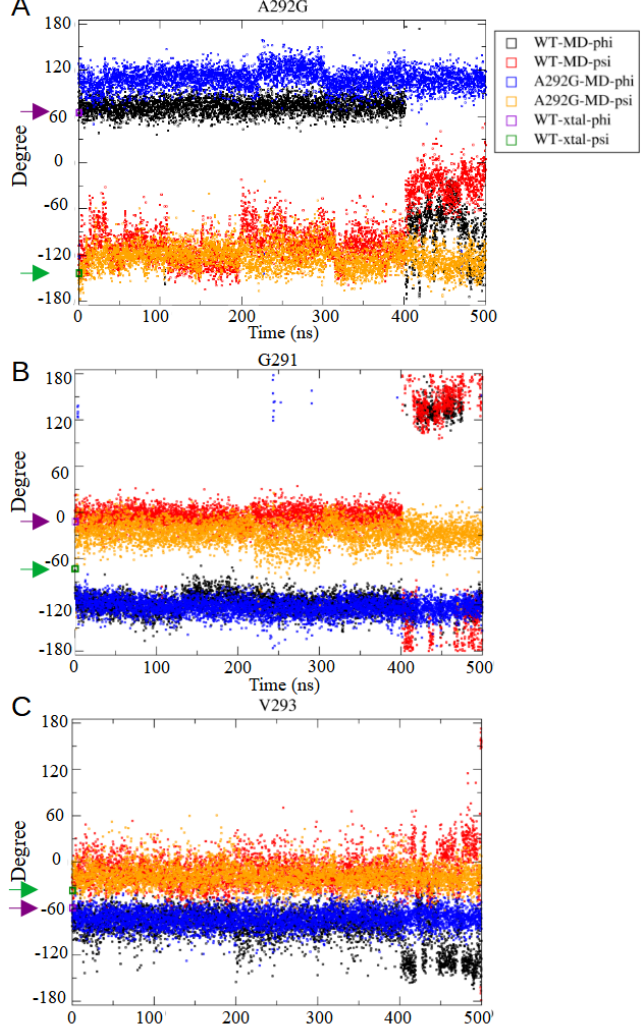
Figure 10. Dihedral angles of residue 292 and neighboring residues in the MD simulation of the WT and the A292G mutant. Dihedral angles of residues ( A ) 292, ( B ) 291, and ( C ) 293 in the MD simulation are shown for the WT (phi, black; psi, red) and the A292G mutant (phi, blue; psi, orange). Phi–psi angles in the crystal structure (xtal) are denoted as purple (phi) and green (psi) squares at x = 0 and highlighted by arrows.